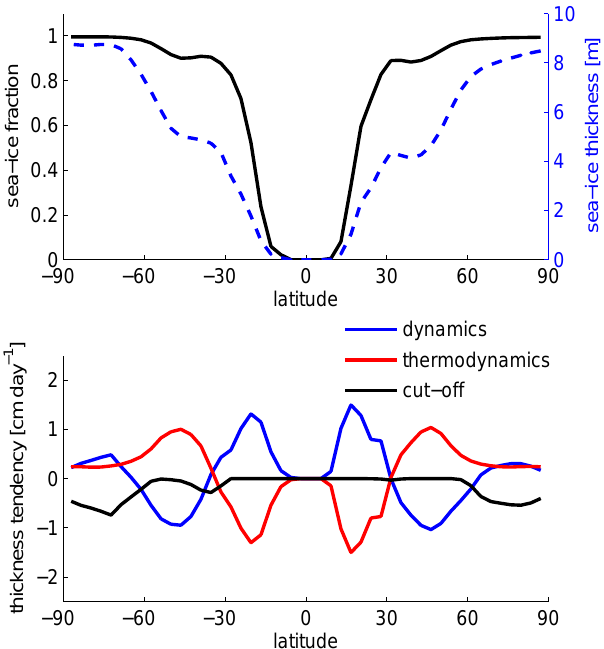
Fig. 4. Simulation with low bare sea-ice albedo and 209ppm CO 2 , which results in 70 % sea-ice cover. Top: zonal-mean annual-mean sea-ice fraction (black) and sea-ice thickness (blue). Bottom: zonal-mean annual-mean sea-ice thickness tendencies due to sea-ice dynamics (blue), sea-ice thermodynamics (red), and the cut-off of sea-ice thicker than 8 m (black).